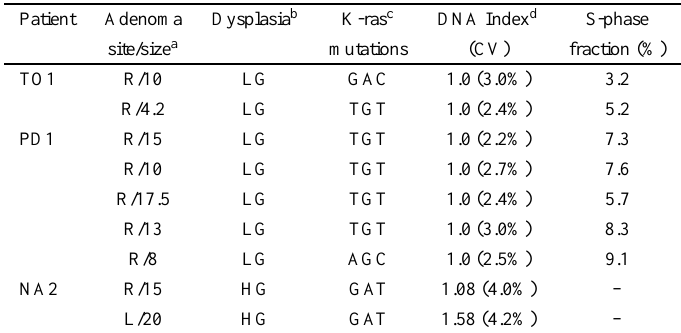
Adenoma site/size, dysplasia, specific K-ras2 mutations, DNA Index, and S-phase fraction values of 9 K-ras2 mutated FAP colorectal adenomas